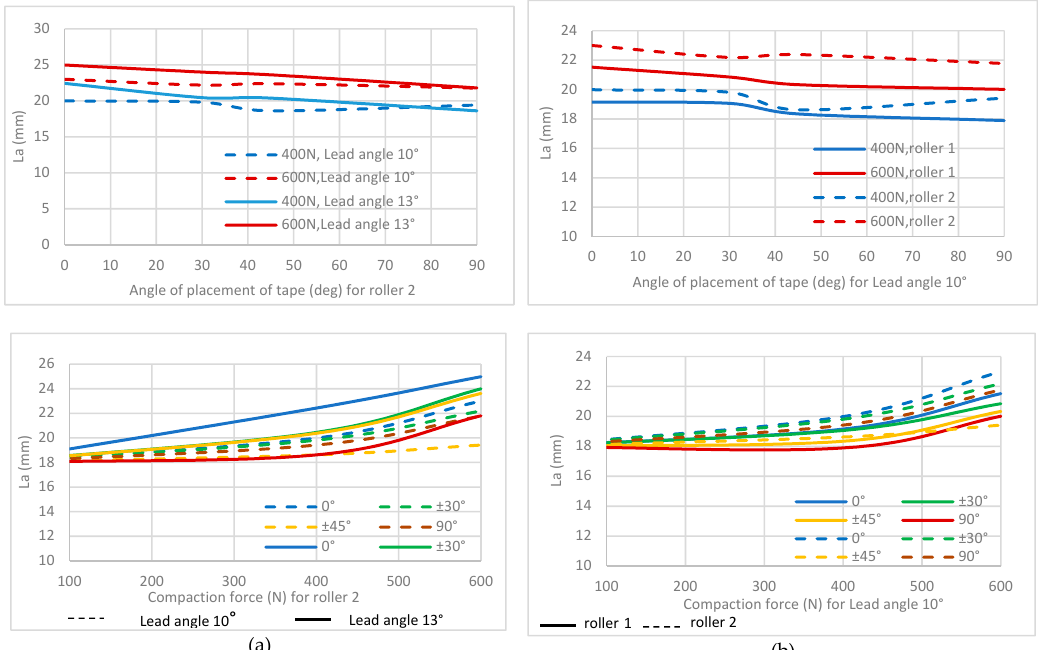
Figure 6. Influence of compact force on the contact line, La, from different angles of laying up; ( a ) for two different lead angles (10 ◦ and 13 ◦ ); ( b ) for two rollers of different thicknesses (5 and 15 mm).